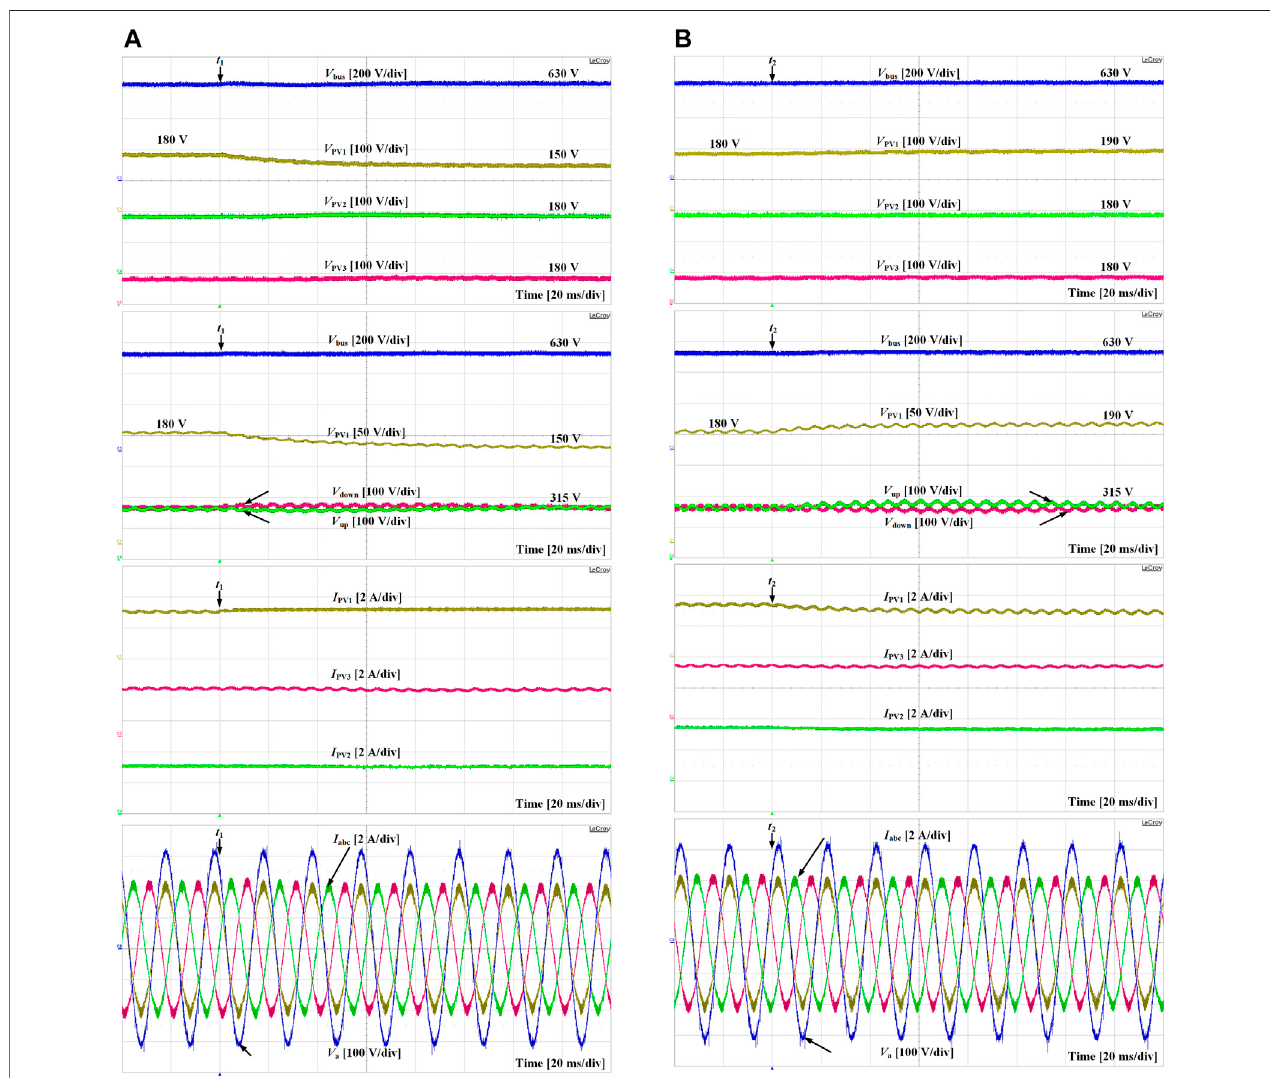
FIGURE 19 | Experimental waveforms when (A) PV1 reference declines from 180 V to 150 V at instant t 1 and (B) PV1 reference rises up from 180 V to 190 V at instant t 2 .